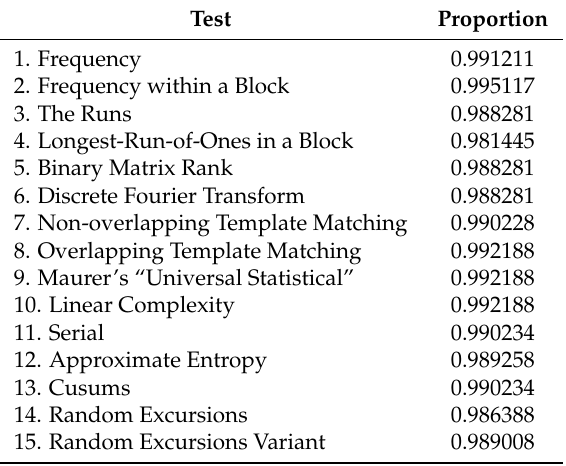
Table 4. Proportion of the 1024 sequences generated by Salsa20 that passed each STS